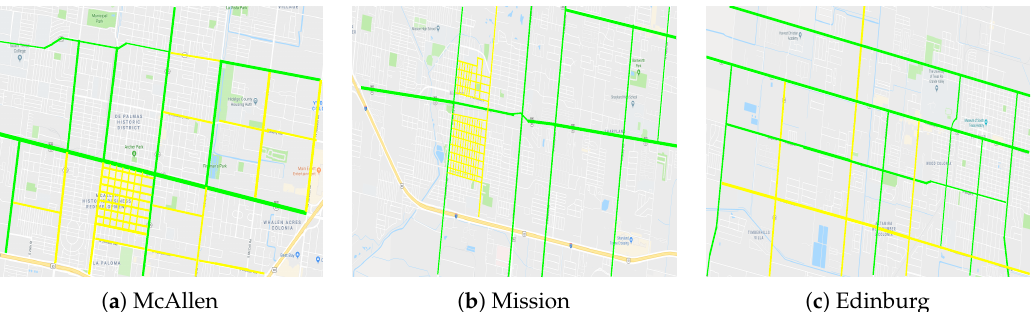
Figure 3. Marked spots in the map represent the streets we recorded to obtain our train and test data, green marks are annotated and yellow are